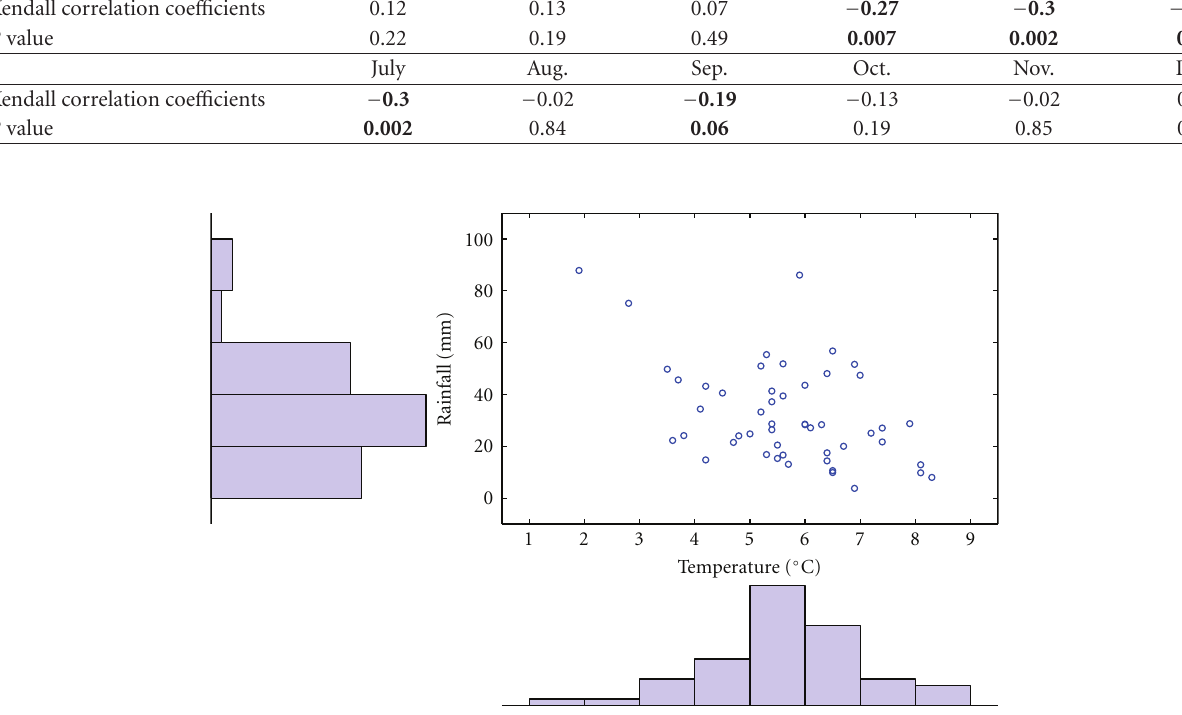
Figure 3: Temperature and rainfall in April from 1961 to 2010.